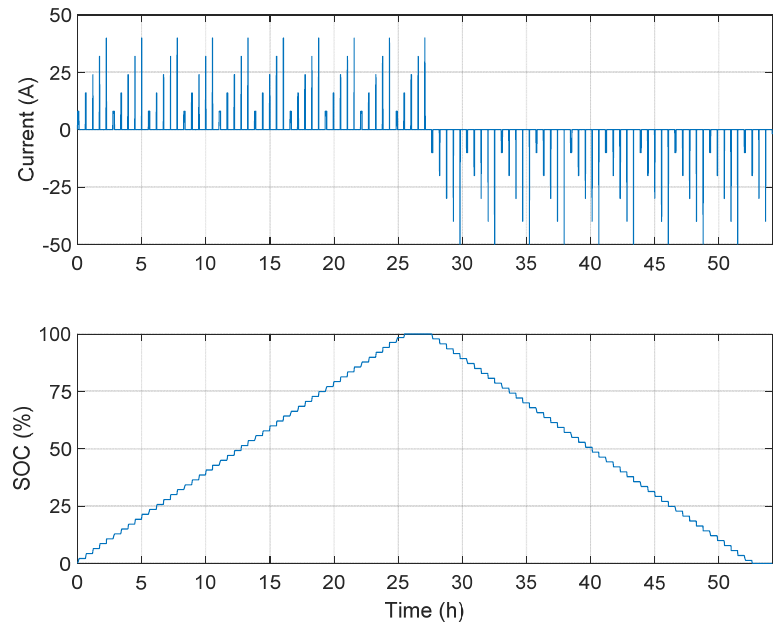
Figure 10. Lithium-ion battery parameter extraction test current and SOC.